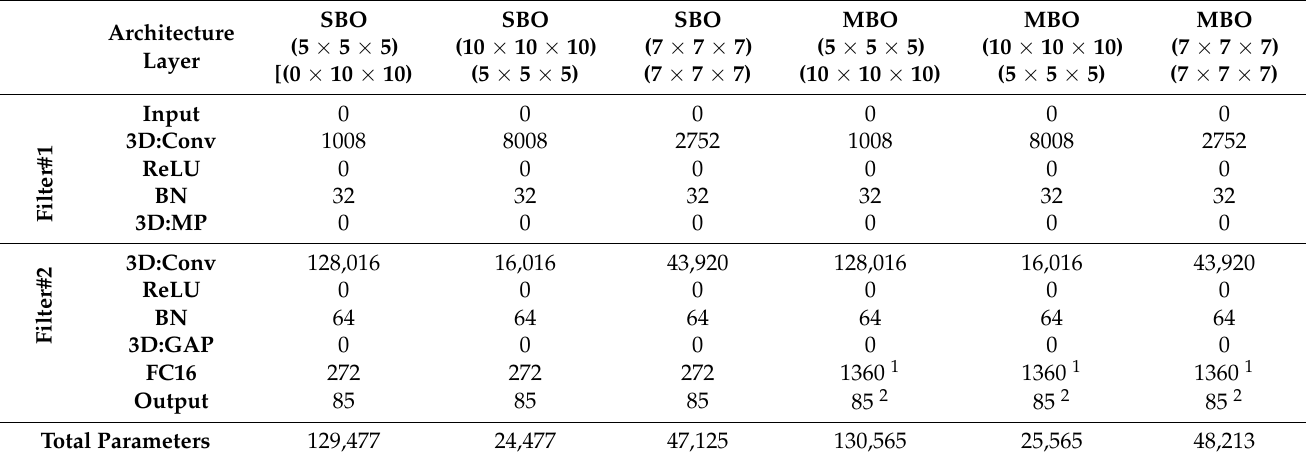
Table 3. Number of parameters per layer and total of SBO and MBO architectures.